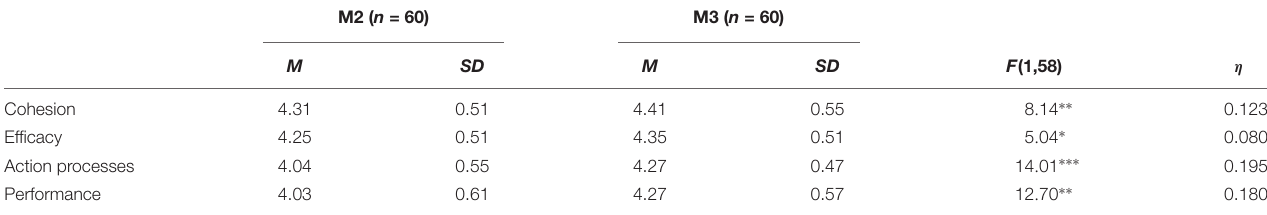
TABLE 4 | Overall main effect of scenario on changes in team